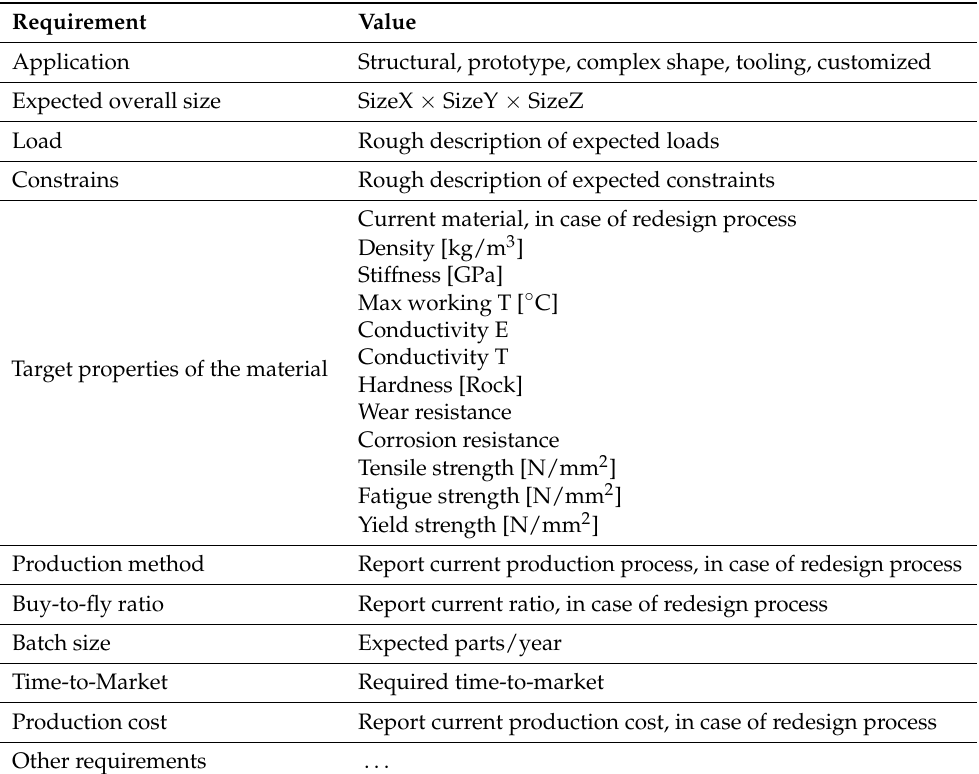
Table 4. Example of initial requirements of a product to be